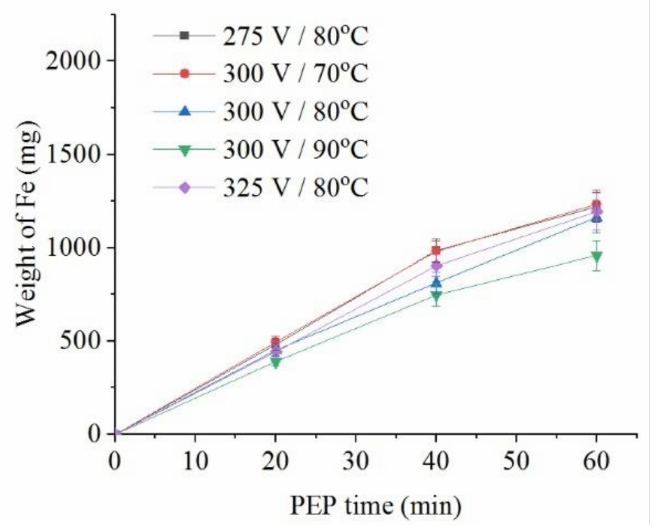
Figure 9. Dependence of iron weight dissolved from the nitrided samples on the PEP duration in ammonium sulfate (3%) solution under natural convection of electrolyte conditions at different voltages and electrolyte